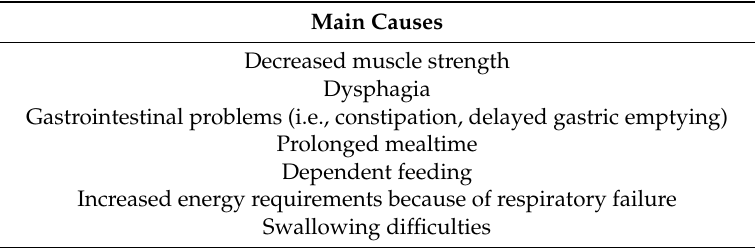
Table 2. Undernutrition in patients with neuromuscular diseases